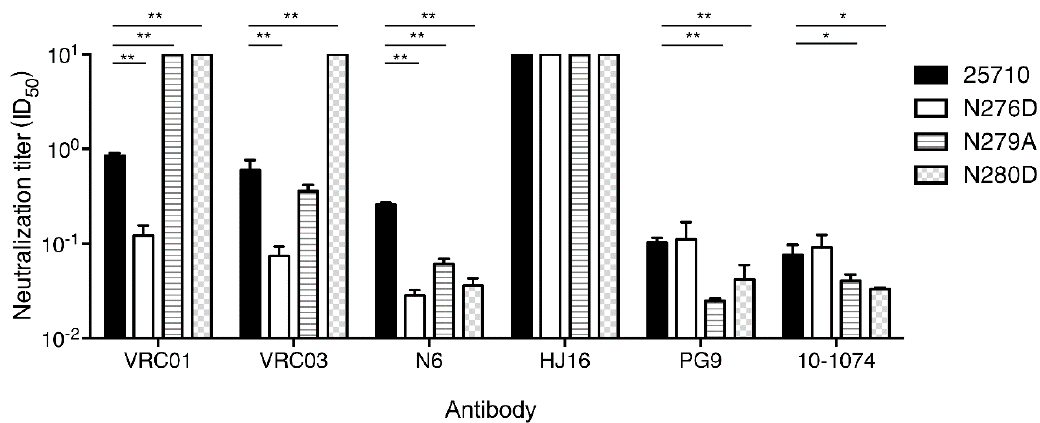
Figure 7. Neutralization susceptibility of loop D mutants to various bnAbs. The neutralization sensitivity of loop D mutants (N276D, N279A and N280D) of 25710 was determined using bnAbs that target CD4bs (VRC01, VRC03, N6 and HJ16), V2 apex (PG9) and V3 glycan (10–1074). Statistical analysis was performed by unpaired t test (*: 0.05 > p > 0.01; **: p < 0.01).